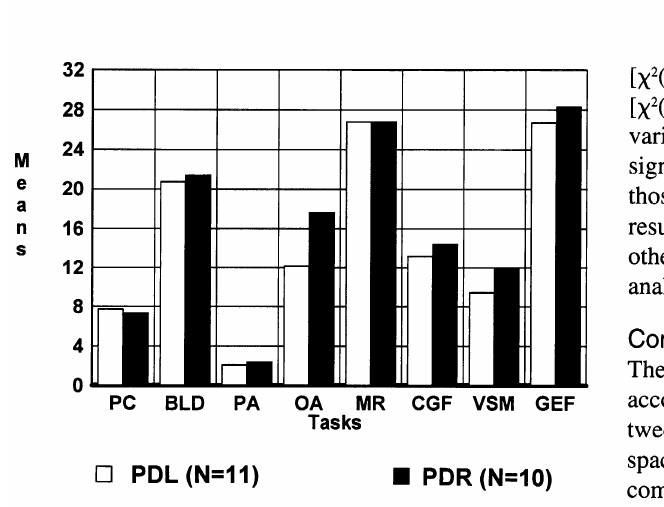
FIG. 1. Performance by PD patients and NCs on the eight tasks. FIG. 3. Differences in performance by EDD and ADD subgroups on the eight tasks.